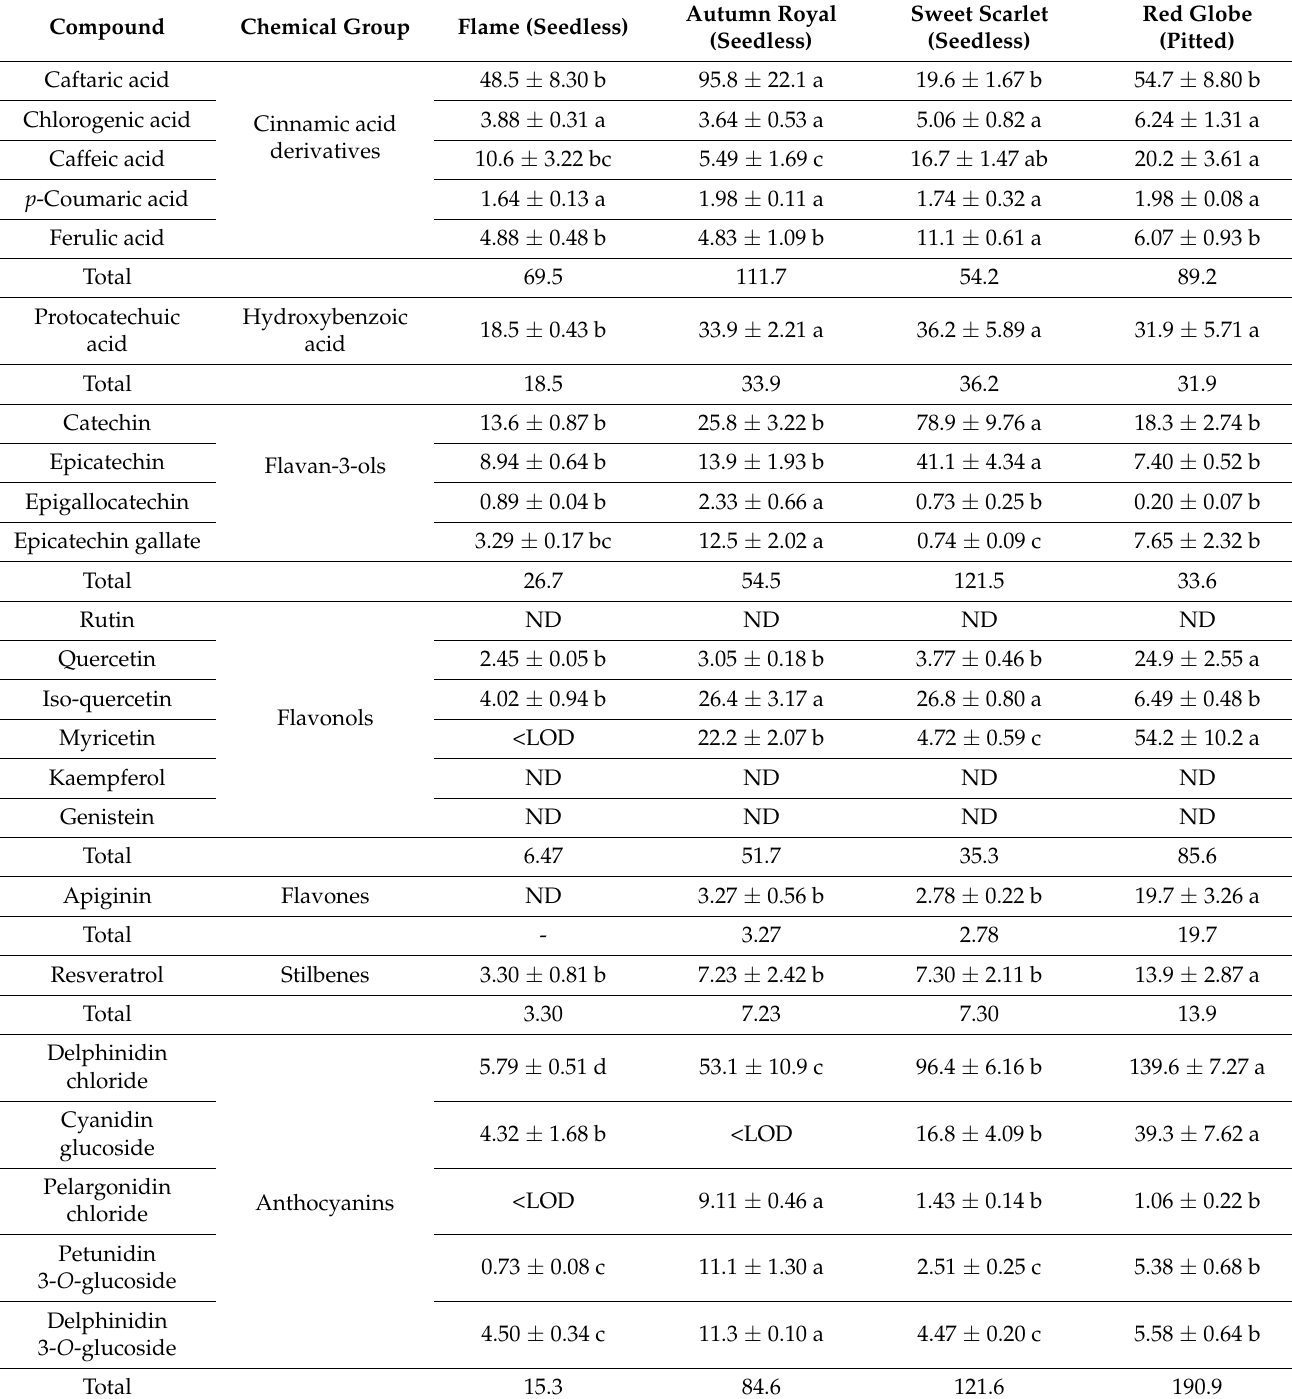
Table 1. Phenolic compounds content ( µ g/g dry weight) identified and quantified in the whole freeze-dried grape varieties using